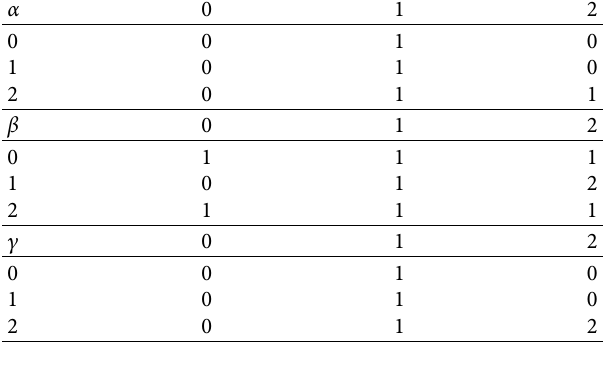
Table 3: Cayley tables for the binary operations “ α , β , and c .”